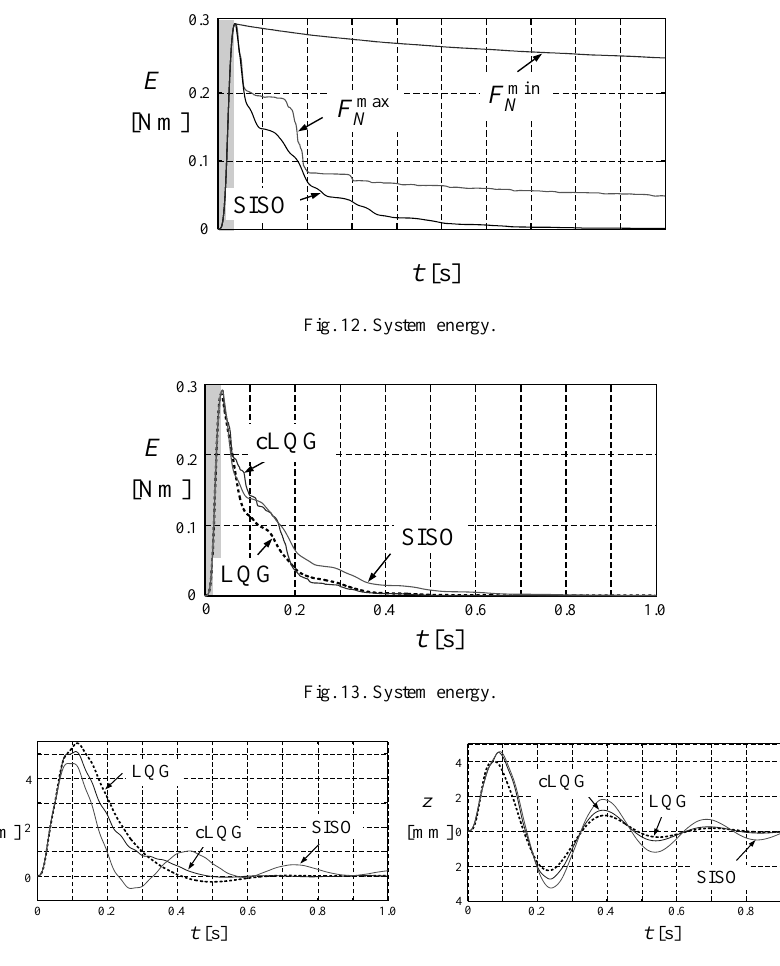
Fig. 14. Deflection of the mast tip: y -direction (left), z -direction